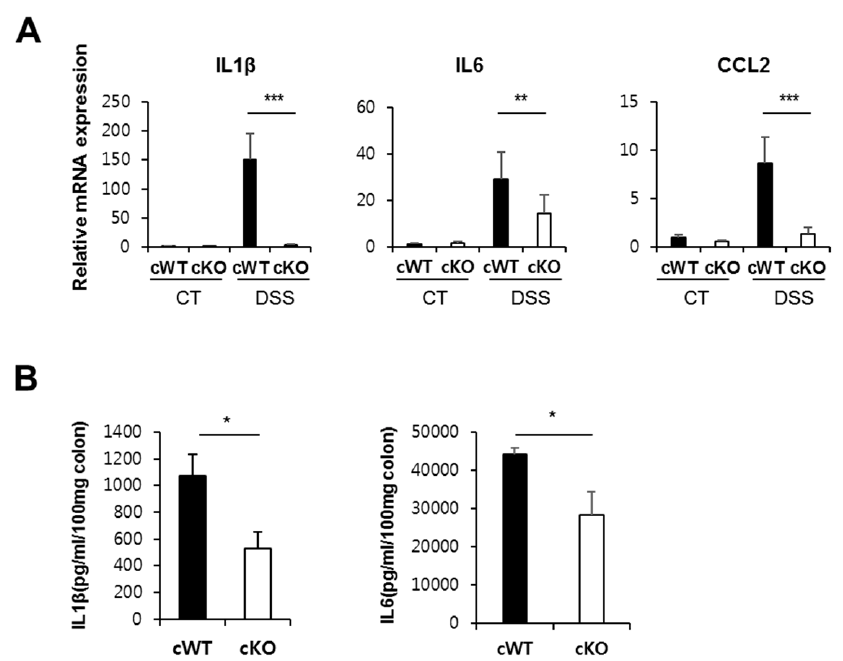
Figure 7. Ninj1 deficiency on macrophages diminishes production of cytokines during DSS treatment. ( A ) Relative mRNA expressions of IL1 β , IL6, and CCL2 extracted from colons of cWT and cKO mice. Data are presented as mean ± SEM. ** p < 0.01, *** p < 0.005, Student’s t -test. ( B ) Colonic tissue explants were harvested, and IL1 β and IL6 secretions were assessed by ELISA; n = 4 per group. Similar results were observed in two independent experiments. Data are presented as mean ± SEM. * p < 0.05, Student’s t -test. CT, control.